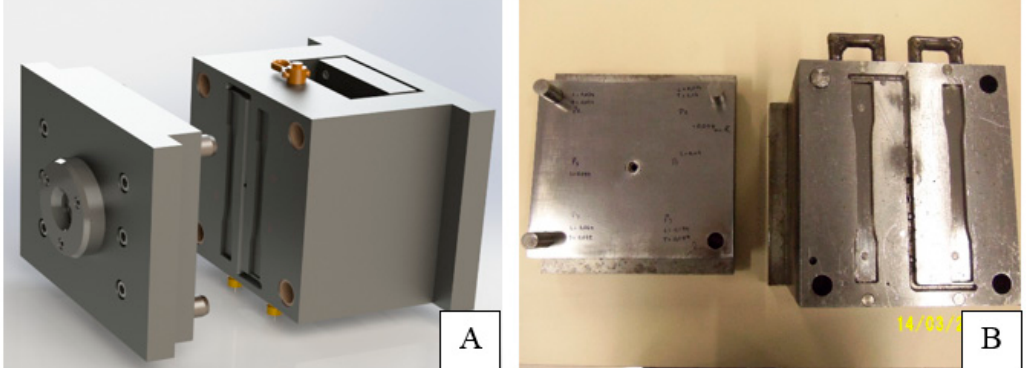
Figure 1. 3D model matrix ( A )/Machined matrix ( B ).